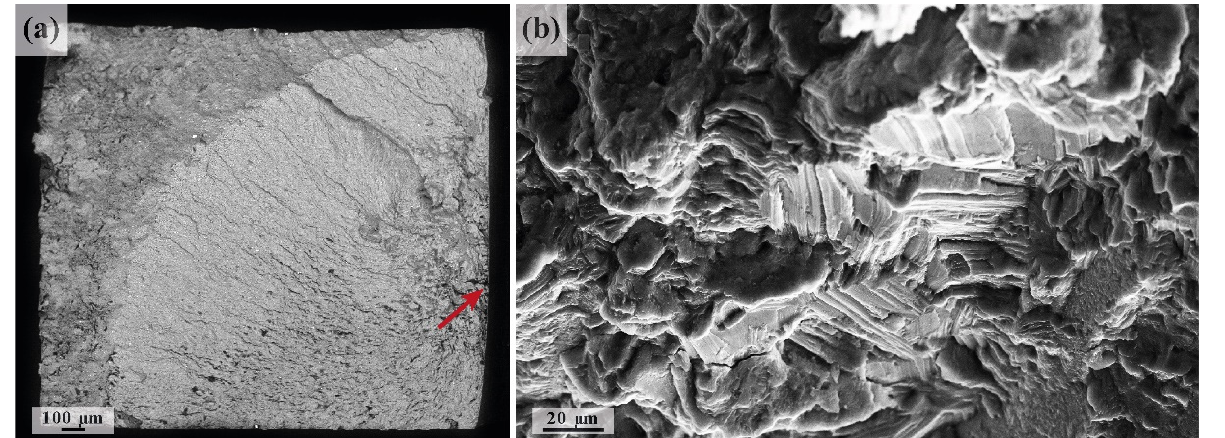
Figure 10. SEM fractography images of the alloy ZK60 specimen fatigued to fracture in air: ( a ) overview of the fracture surface ( a ) and a magnified view of the crack initiation site ( b ), pointed to by a red arrow in ( a ).